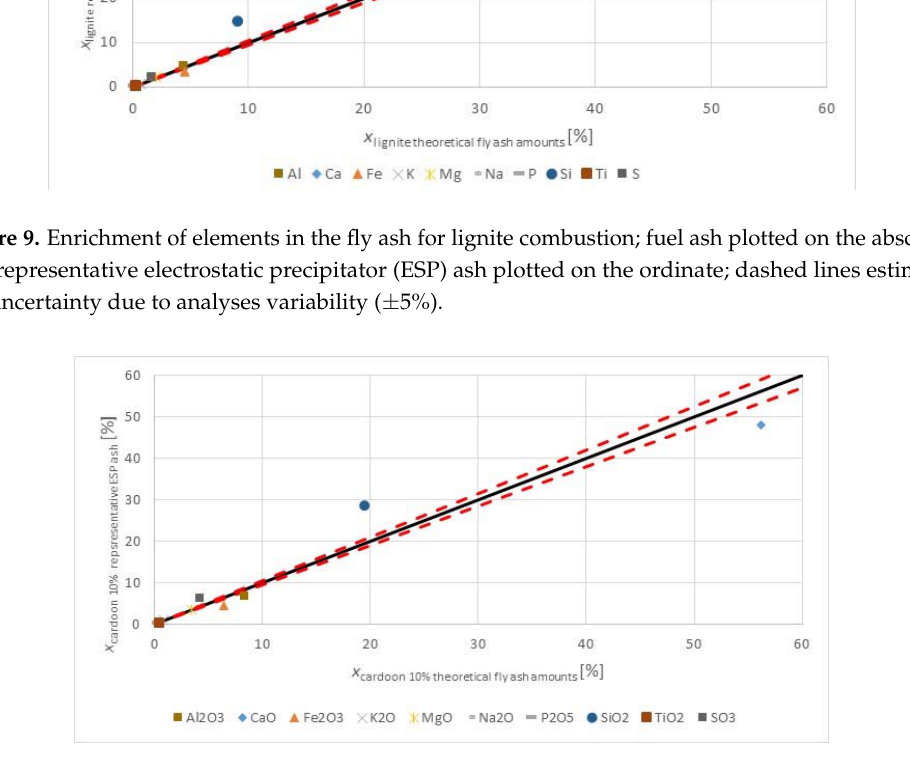
Figure 10. Enrichment of elements in the fly ash for 10% thermal share of Cynara ; fuel ash blend plotted on the abscissa and representative ESP ash plotted on the ordinate; dashed lines estimate the uncertainty due to analyses variability (±5%).